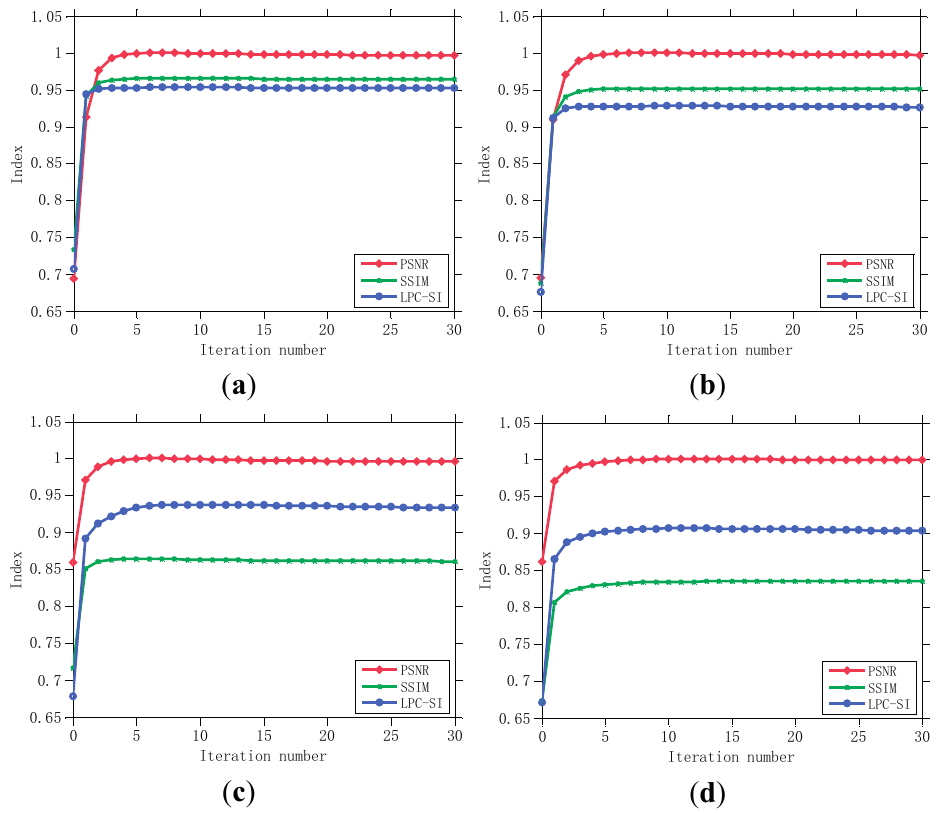
Figure 11. Evolution of PSNR, SSIM, and LPC-SI with iterations in the different cases. ( a – d ) correspond to the iterations of Figures 5–8a, respectively. The PSNR values have been normalized for